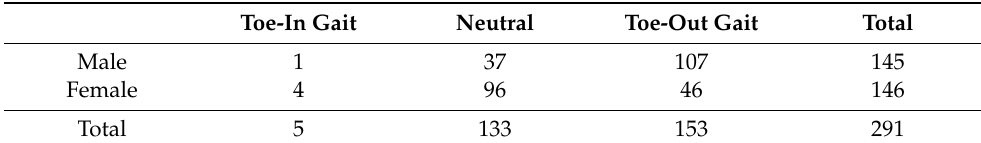
Table 8. Cross tabulation analysis of toe-in gait/toe-out gait by gender (X 2 = 52.29, DF = 2, p -value = 0.00).